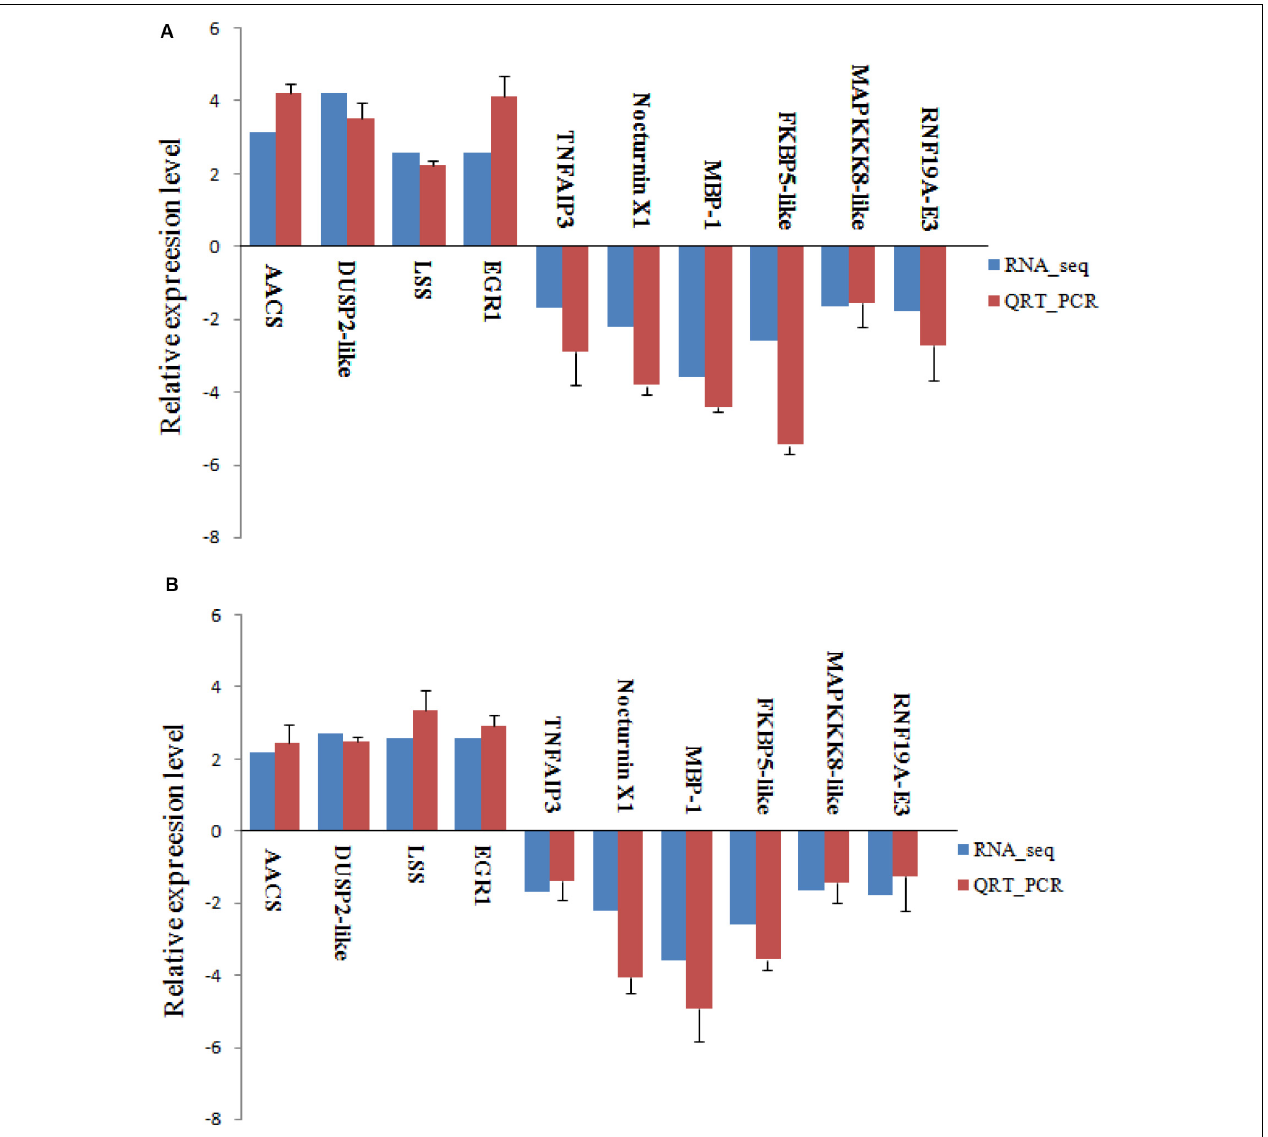
FIGURE 9 | Validation of RNA-seq data by qRT-PCR analysis. Relative expression of gene expression was log2 (fold change) ( A , 48 h; B , 96 h). The relative expression of 10 random genes, were determined by RT-qPCR (blue column) and RNA-seq (red column). Error bars represented standard deviation (SD, n =